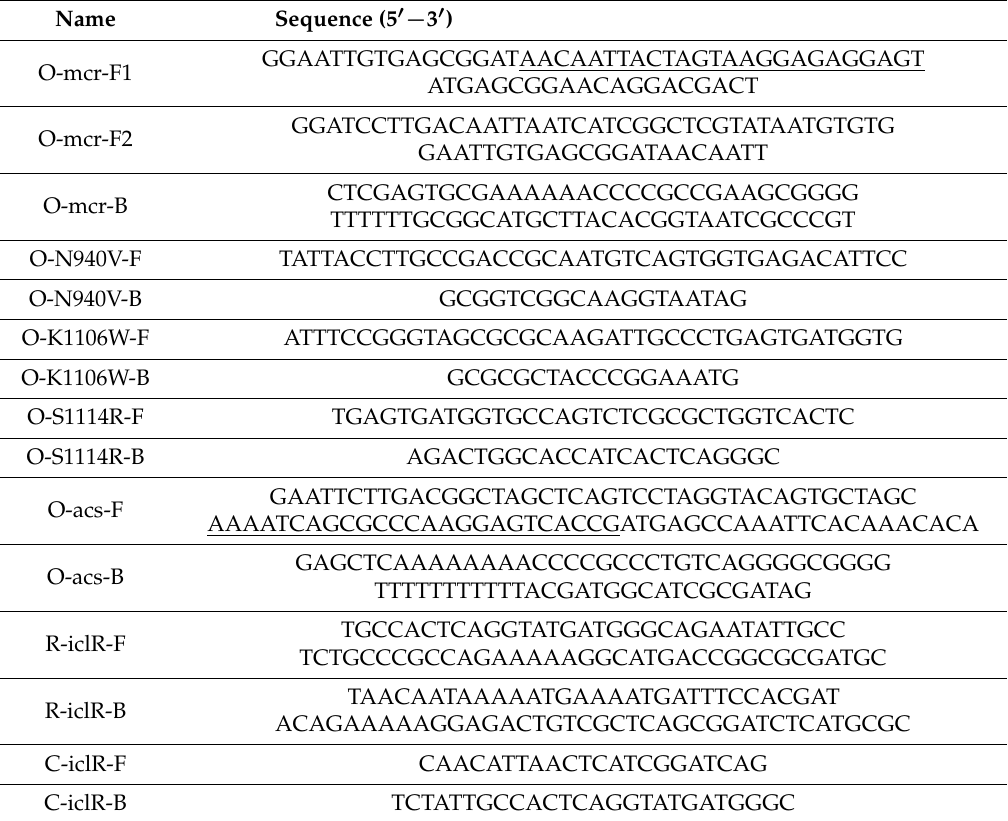
Table 3. Oligonucleotides used in this